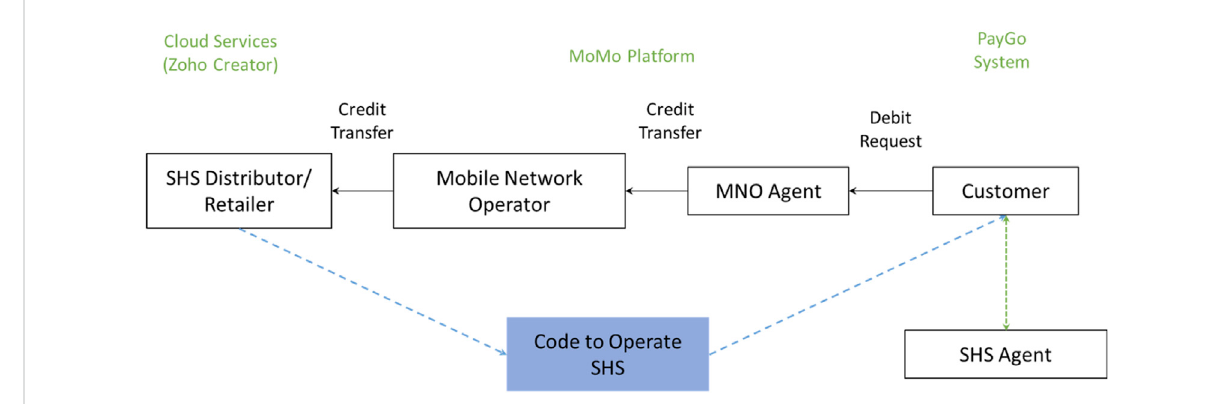
FIGURE 1 Flows of cash and information in the distributor/customer network.